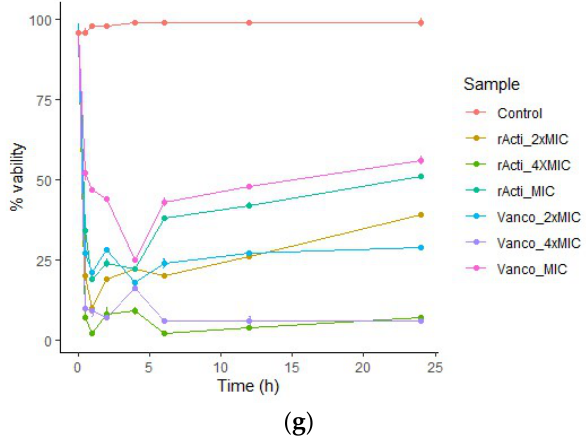
Figure 6. Inhibition kinetics of recombinant peptides: ( a ) C. albicans vs. defensin-d2; ( b ) P. aeruginosa vs. defensin-d2; ( c ) E. coli vs. defensin-d2; ( d ) K. pneumoniae vs. defensin-d2; ( e ) C. albicans vs. actifensin; ( f ) P. aeruginosa vs. actifensin; ( g ) MRSA vs. actifensin. Graph shows means and standard error means (as error bars) of triplicate data per time point.